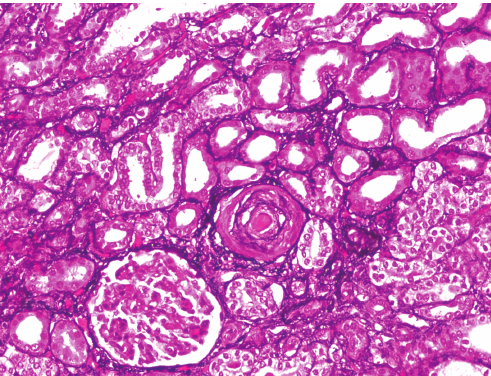
Figure 1: Arterial thrombosis associated with prominent glomeru- lar ischemic collapse in a patient with scleroderma renal crisis (Methenamine silver stain; original magnification